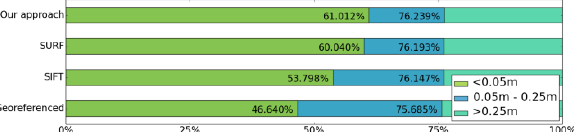
Figure 14. Point cloud alignment comparison between different